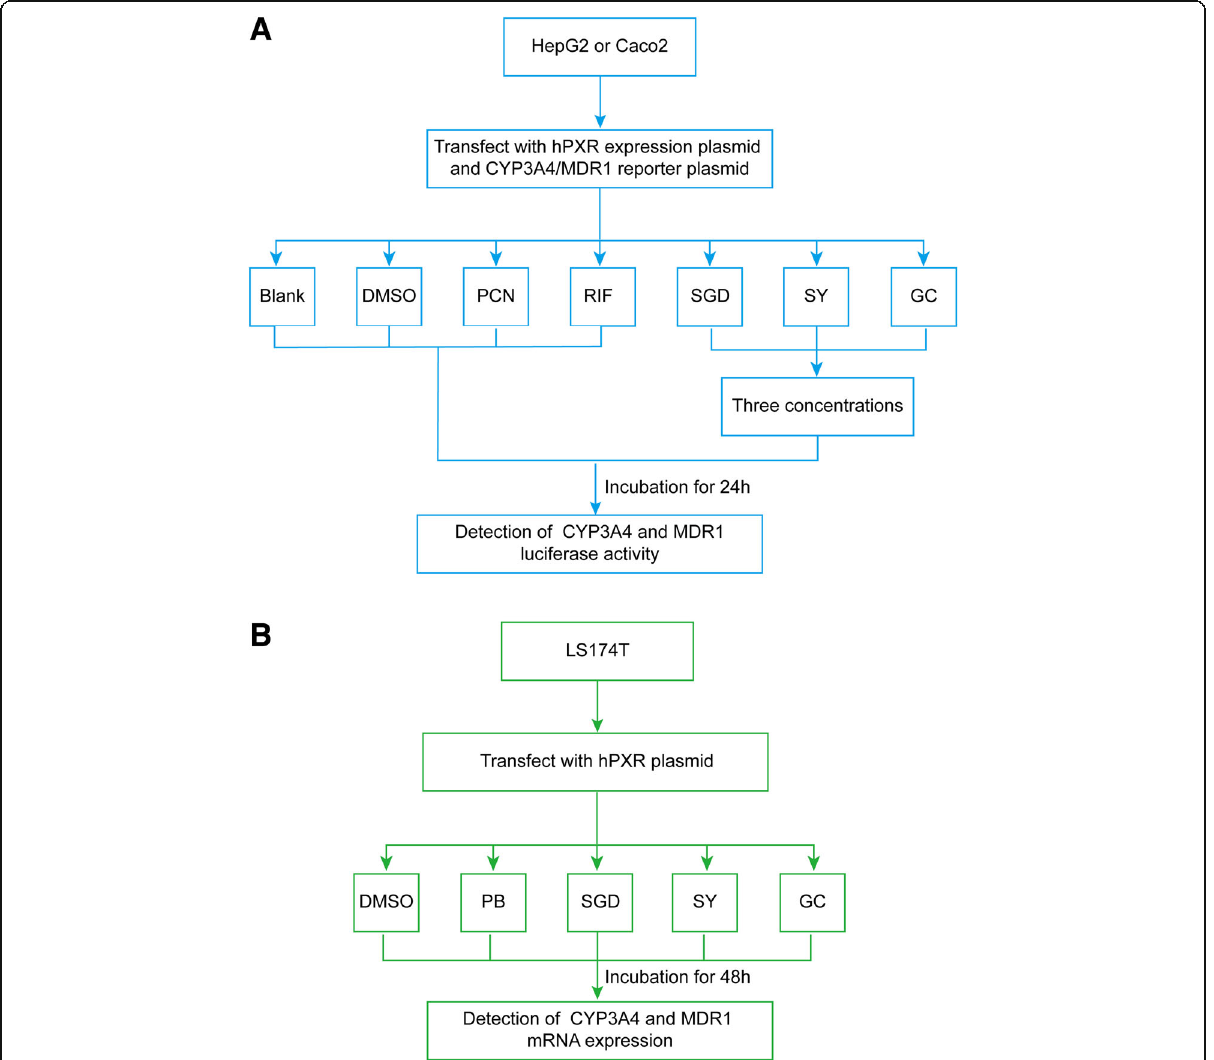
Fig. 1 The workflow of the present study. a The workflow of the study that whether SGD regulates CYP3A4 or MDR1 luciferase activities through hPXR. HepG2 and Caco2 cells were co-transfected with a PXR-expressed CYP3A4 or MDR1 dual luciferase reporter gene constructs and then exposed to a range of SGD, or Shaoyao (SY), or Gancao (GC). After 24 h, luciferase activities were evaluated. b The workflow of the study that whether SGD regulates CYP3A4 or MDR1 mRNA expression through hPXR. LS174T cells were co-transfected with PXR plasmid and then exposed to SGD, or Shaoyao (SY), or Gancao (GC). After 48 h, CYP3A4 and MDR1 mRNA expression were